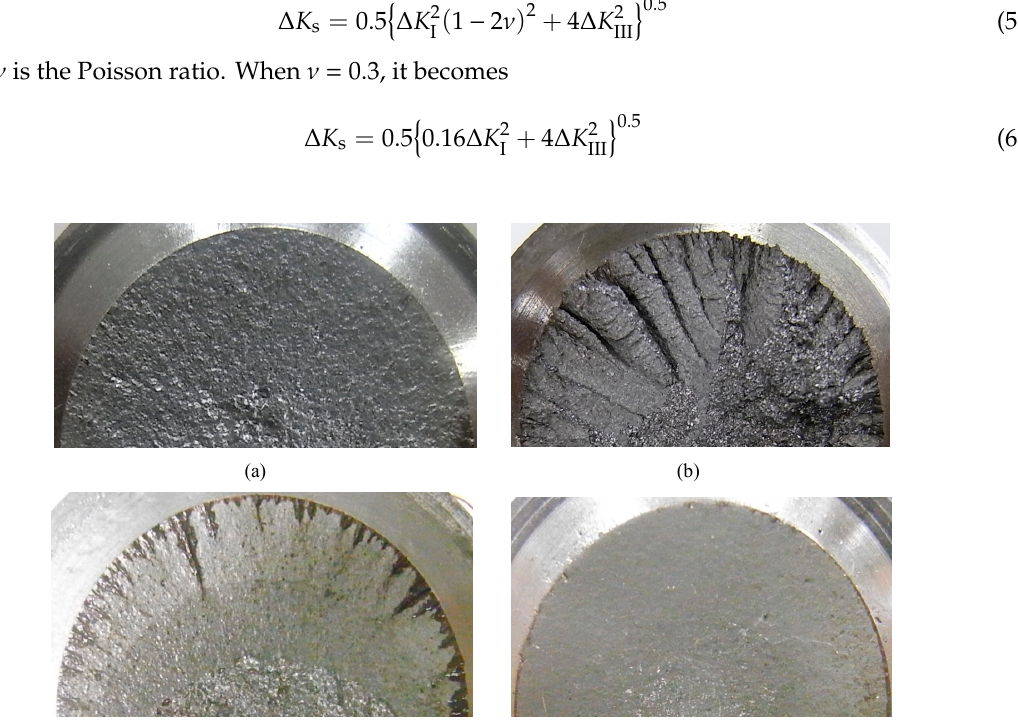
Figure 6. Macroscopic fracture surface of ( a ) RP2 ( Δ K III / Δ K I = 1.5, δ = 90°), ( b ) RP5 ( Δ K III / Δ K I = 1.5, δ = 180°), ( c ) RF2 ( Δ K III / Δ K I = 1.5, δ = 60° → 30°) and ( d ) WT1 ( Δ K III / Δ K I = 1.0, δ = 90° → 60°).